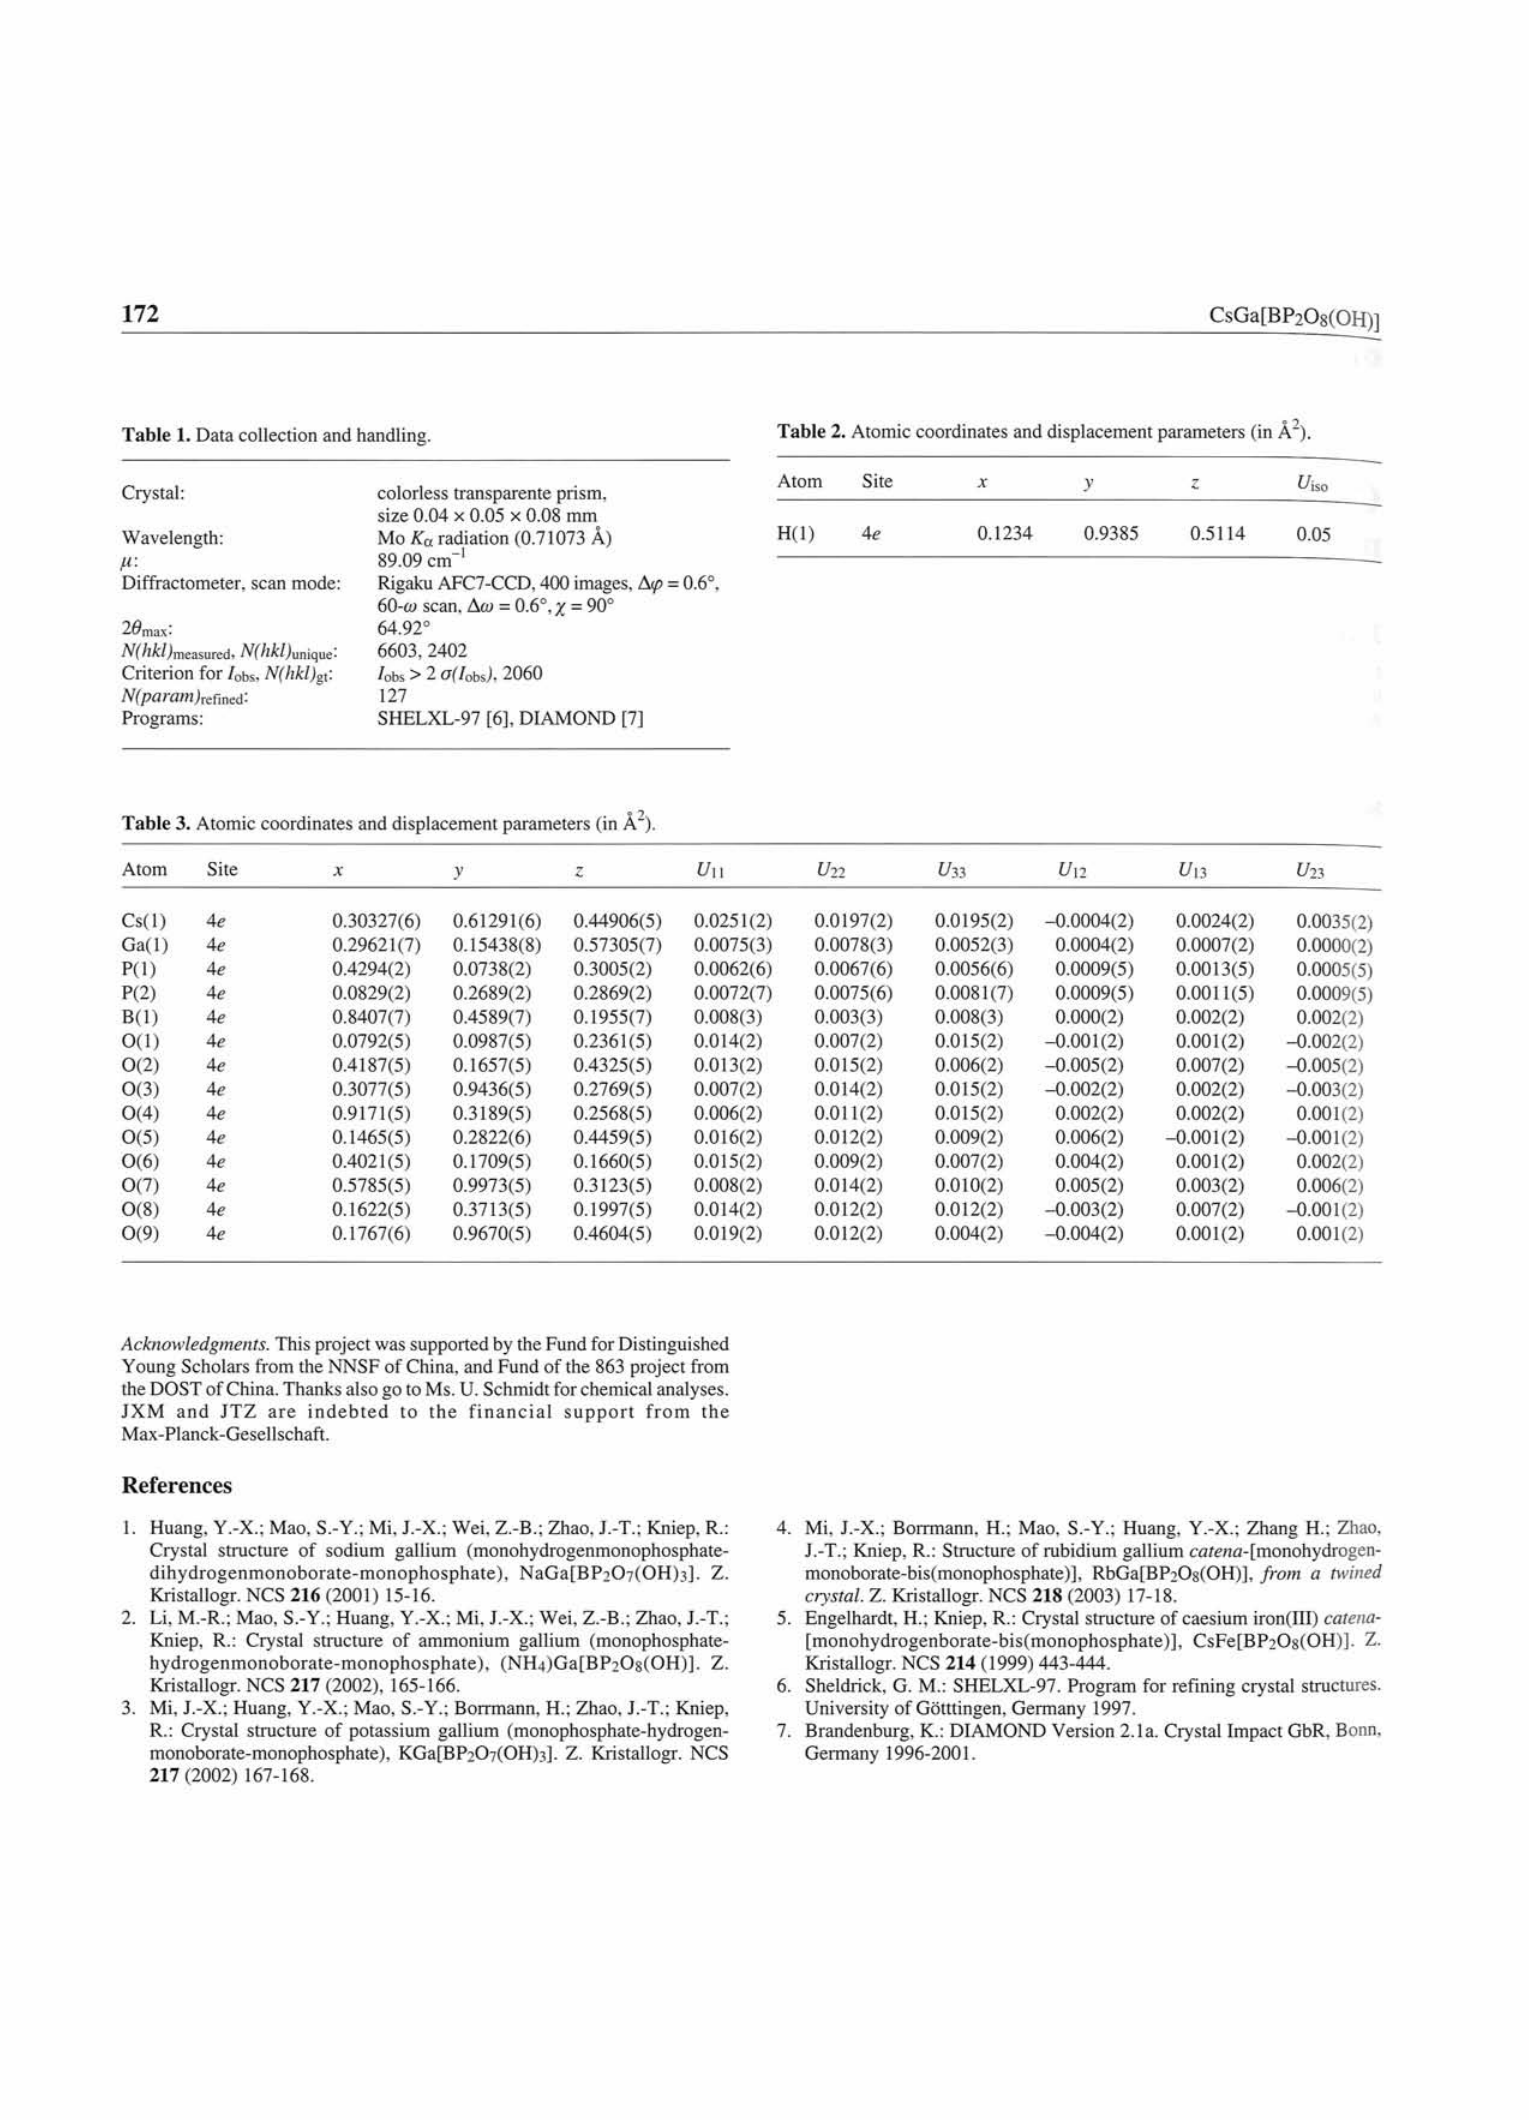
Table X. Data collection and handling. Table 2. Atomic coordinates and displacement parameters (in A").